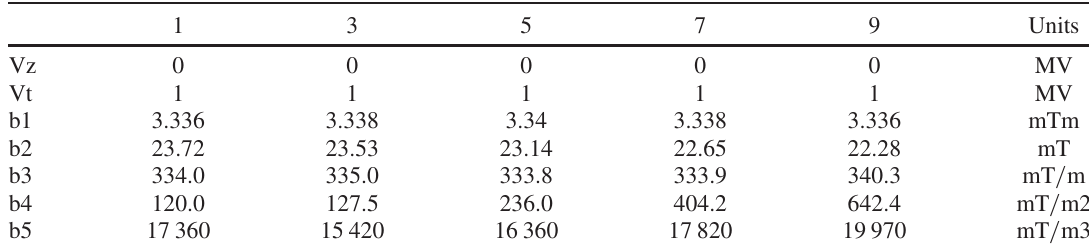
TABLE V. Multipole components for the 5 odd harmonics.